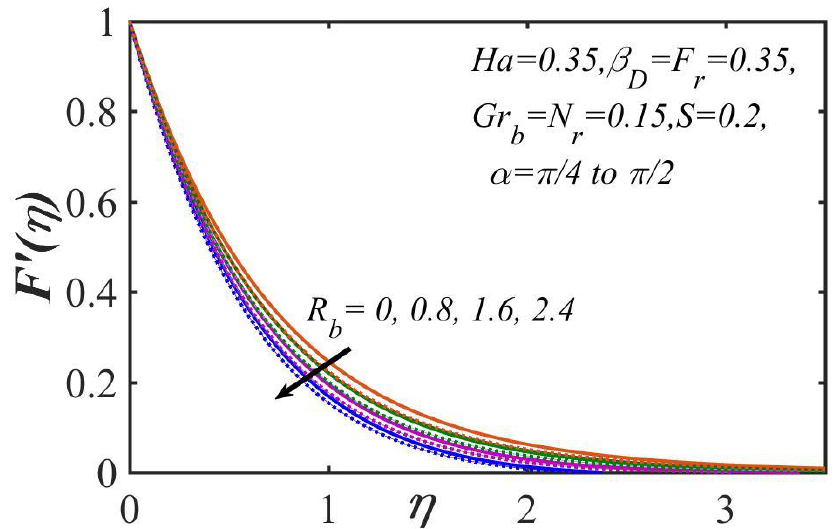
Figure 5. Effects of 𝑅 𝑏 and 𝛼 on velocity magnitude. Solid curve: 𝛼 = 𝜋/4 ; dotted curve: 𝛼 = 𝜋/2 .